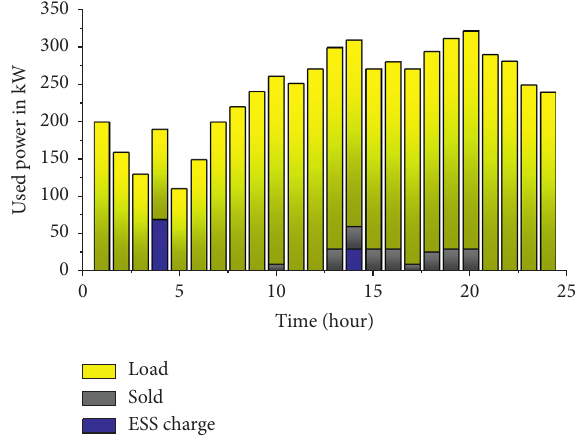
Figure 11: Optimum power consumption in the MG regardless of the fixed subsidies.